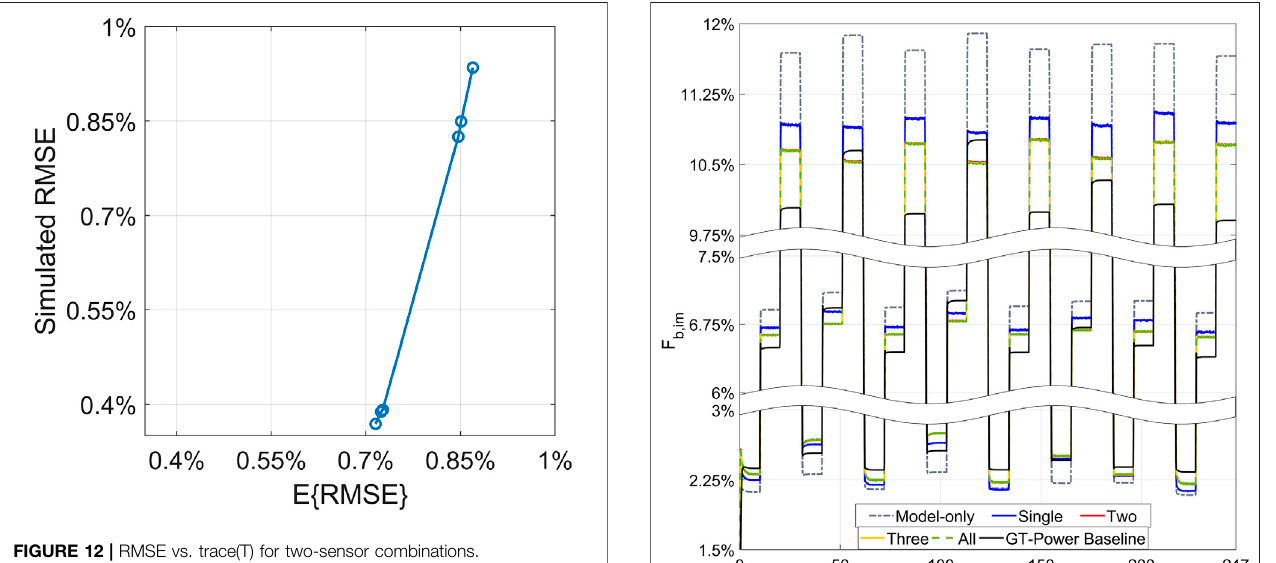
FIGURE 12 | RMSE vs. trace(T) for two-sensor combinations.